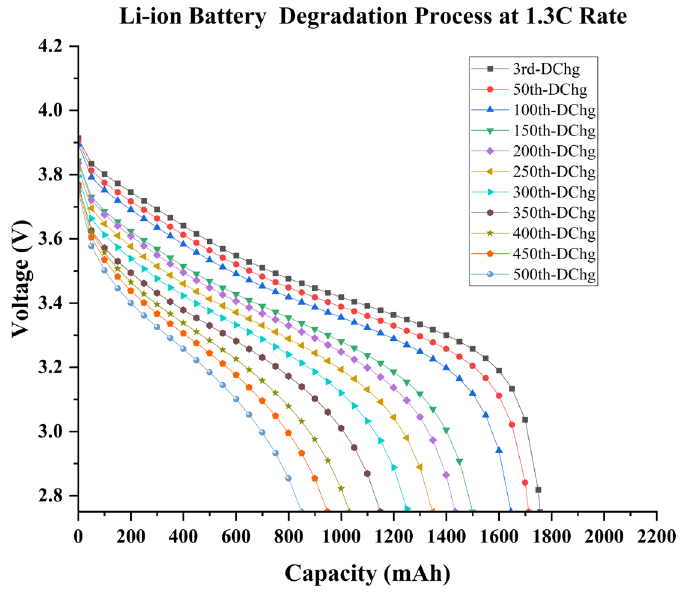
Figure 6. The battery degradation process at 1.3 C-rate for 500 cycles, where degradation is displayed every 50 cycles.